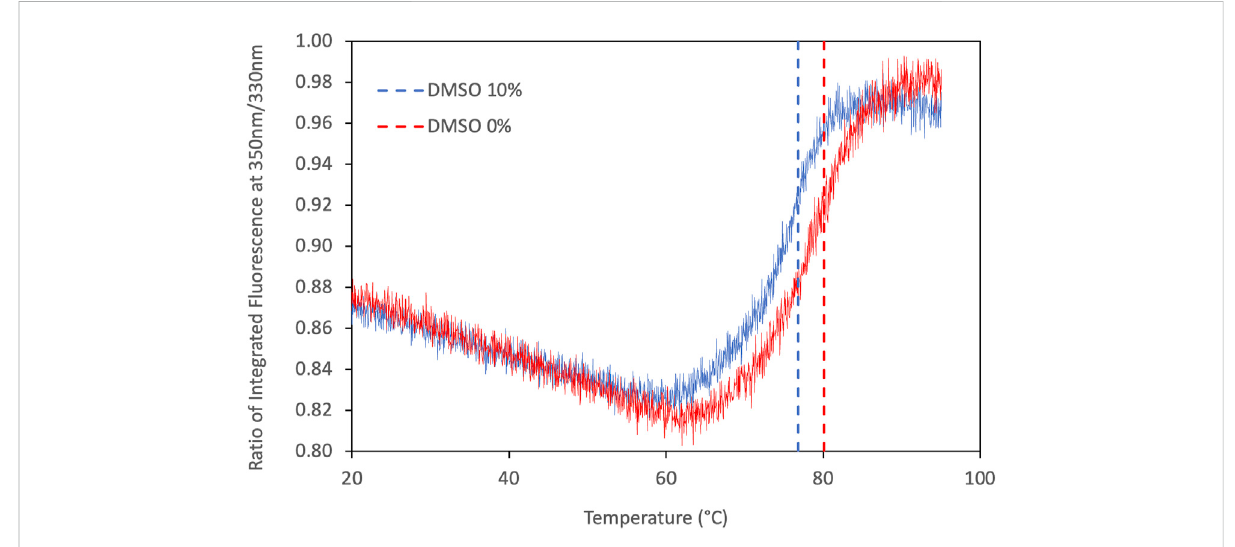
FIGURE 2 Thermograms of HiCut DSF analyses. Dotted lines corresponds to melting temperature in presence of 10% DMSO (77 ° C) and free of DMSO (80 ° C).